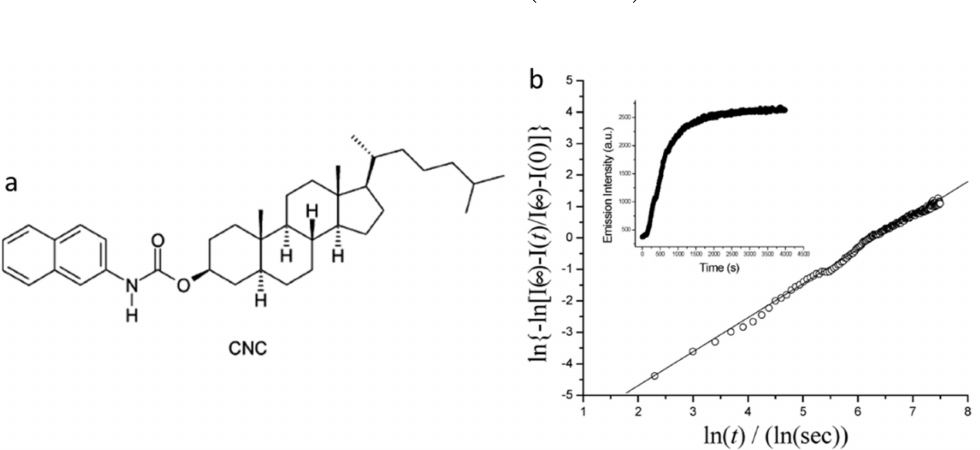
Figure 28. ( a ) Molecular structure of CNC; ( b ) Avrami plot of fluorescence data according to the Avrami equation (slope = 1.08 (R 2 = 1.00)). Inset: Plot of emission intensity ( λ em = 375 nm; λ ex = 318 nm) from a 1.0 wt % CNC in n-octane sample incubated at 1.1 ◦ C. Reprinted (adapted) with permission from [95]. Copyright (2005) American Chemical